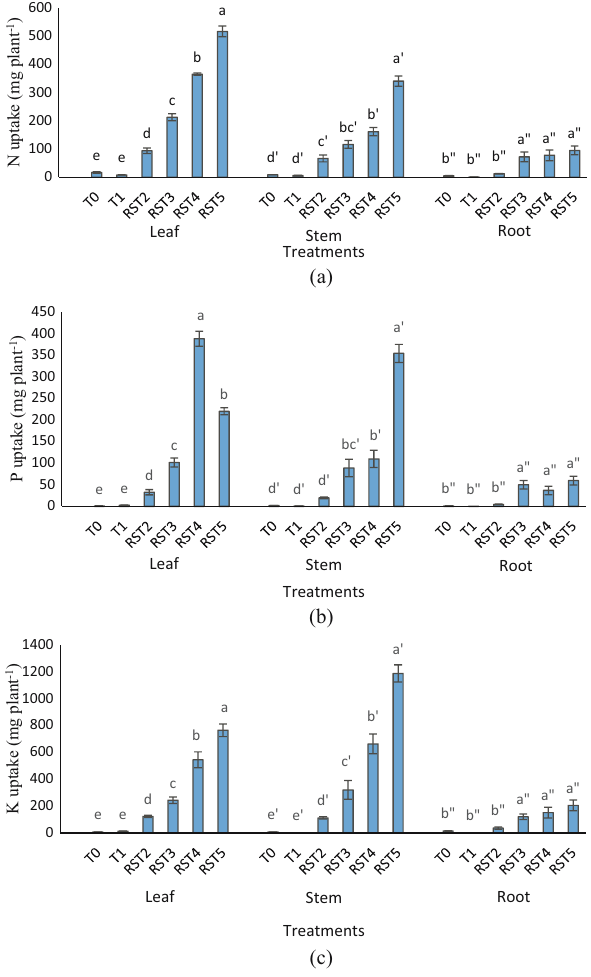
Figure 1: E ff ect of amending CIRP with RS compost on N, P, and K ( a – c ) uptake in leaf, stem, and root of Zea mays L. FI hybrid sweet corn 801 variety at 60 DAS of pot experiment. Note: mean values with di ff erent letter ( s ) indicate signi fi cance between treatments by Tukey ’ s test at P ≤ 0.05. Bars represent the mean values ±